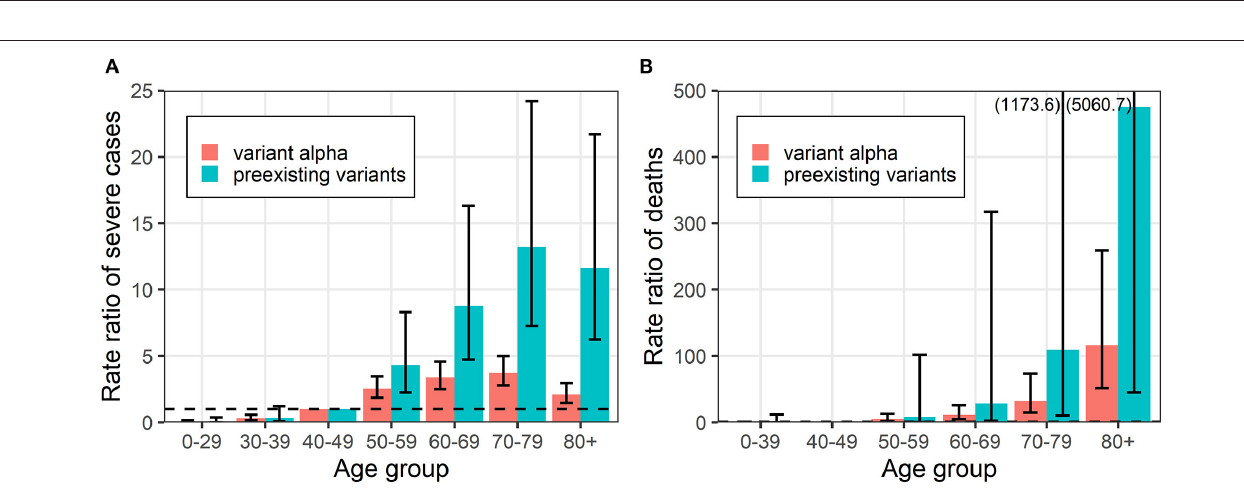
FIGURE 4 | Rate ratios of events due to variant alpha and preexisting strain COVID-19 by age group. (A) Severe cases and (B) deaths are shown. Error bars represent 95% confidence intervals. Values in parentheses represents the upper bound of the 95% confidence